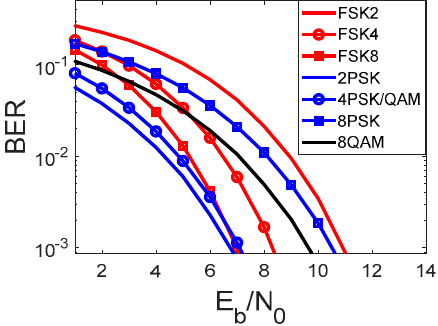
Figure 2. BER curve vs. E b / N 0 for FSK, PSK, and QAM modulation. Figure 2. BER curve vs. 𝐸 (cid:3029) 𝑁 (cid:2868) ⁄ for FSK, PSK, and QAM modulation. Figure 2. BER curve vs. 𝐸 (cid:3029) 𝑁 (cid:2868) ⁄ for FSK, PSK, and QAM modulation.